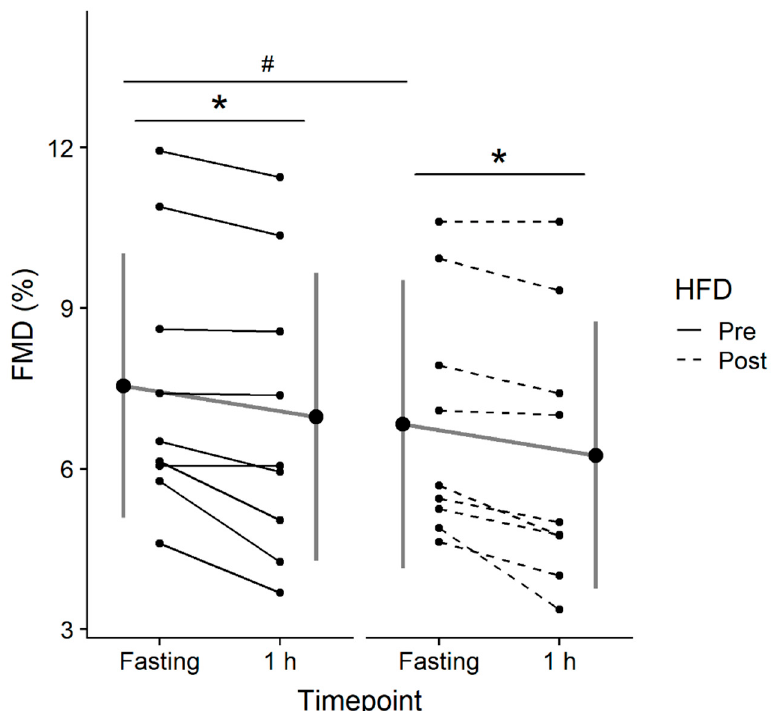
Figure 1. Flow-mediated dilation (FMD) assessed in the fasting state (Fasting) and 1-hour (1 h) following consumption of a 75-g glucose drink pre and post 7-day high fat diet (HFD). Data are expressed as the mean ± standard deviation (gray lines and large circles) and individually (solid and dashed black lines and small circles). Significant difference from Fasting to 1 h is denoted as * ( p < 0.05), significant difference pre vs. post HFD is denoted as # ( p < 0.05).